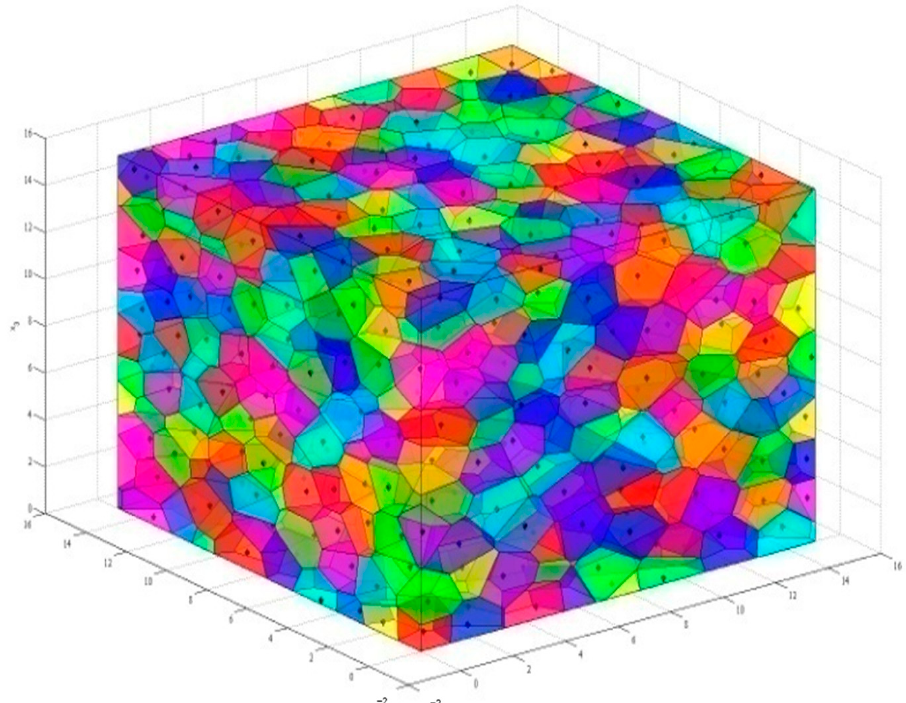
Figure 1. Resulting 3D Voronoi polyhedrons when K = 0.2.